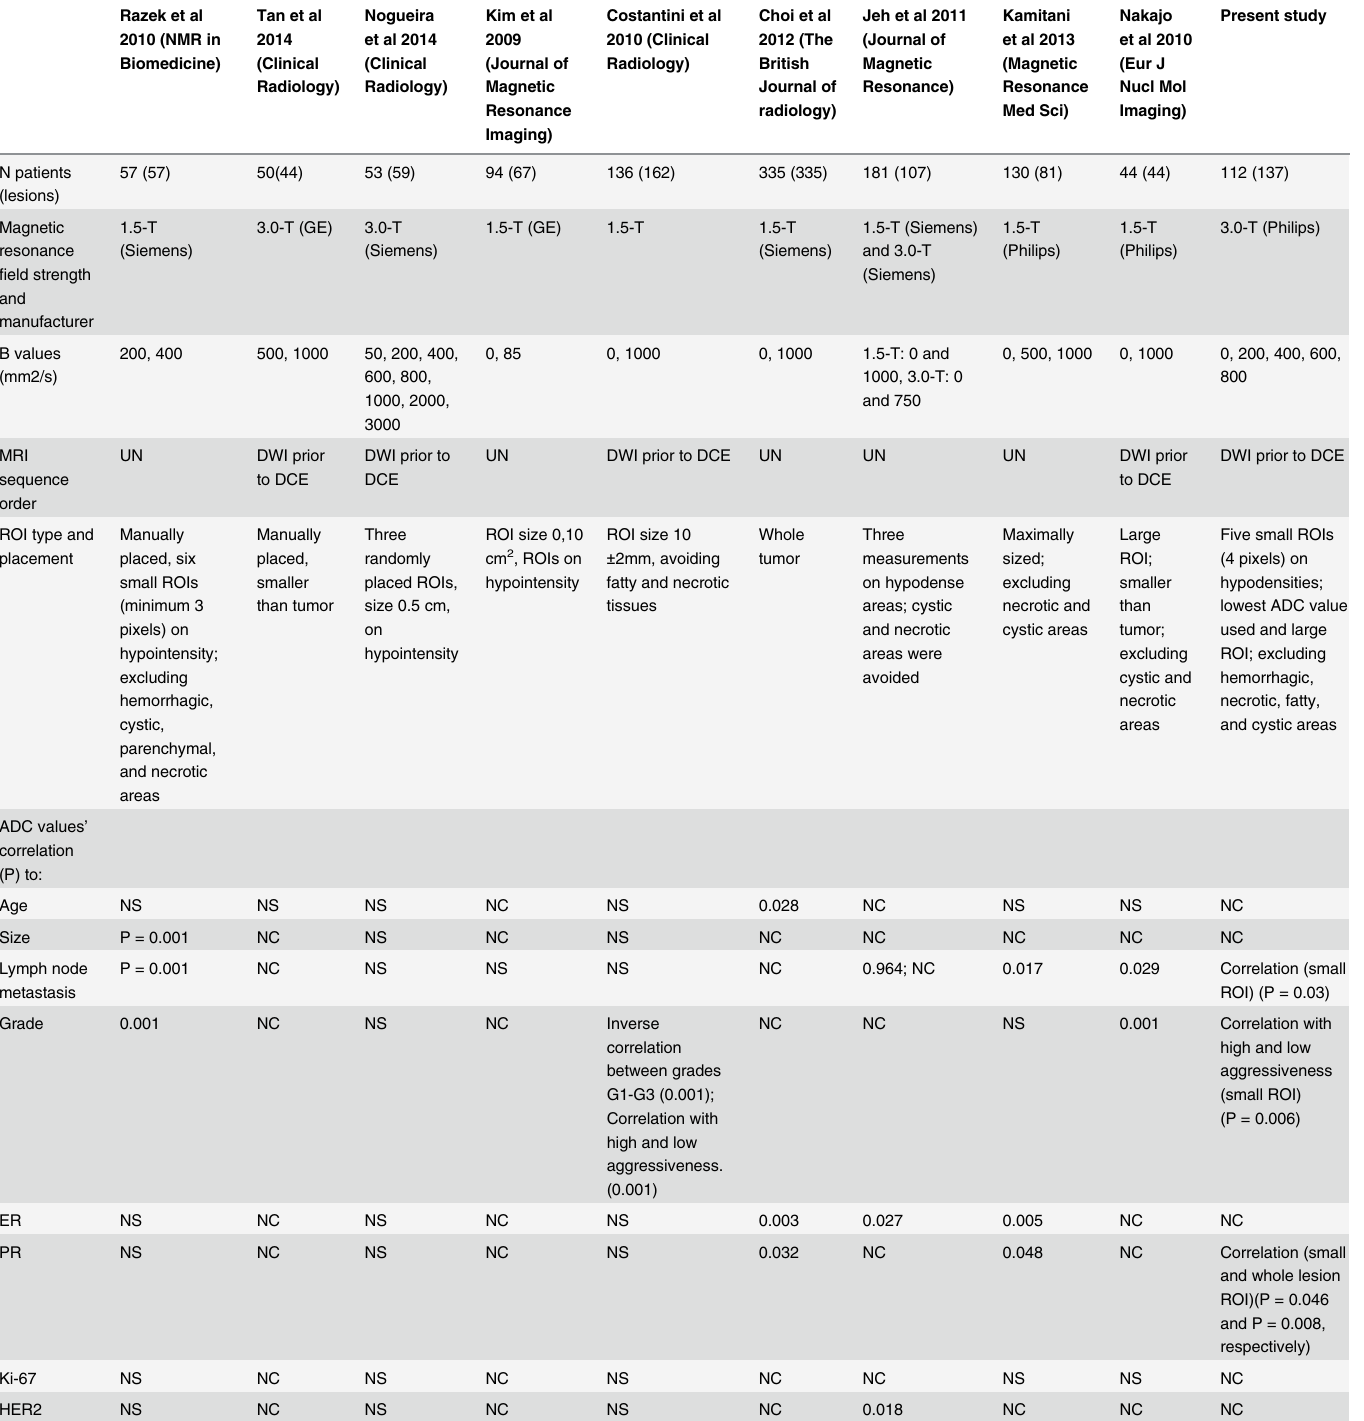
Table 4. Previous publications that address the correlation between apparent diffusion coefficient (ADC) values and prognostic factors in breast